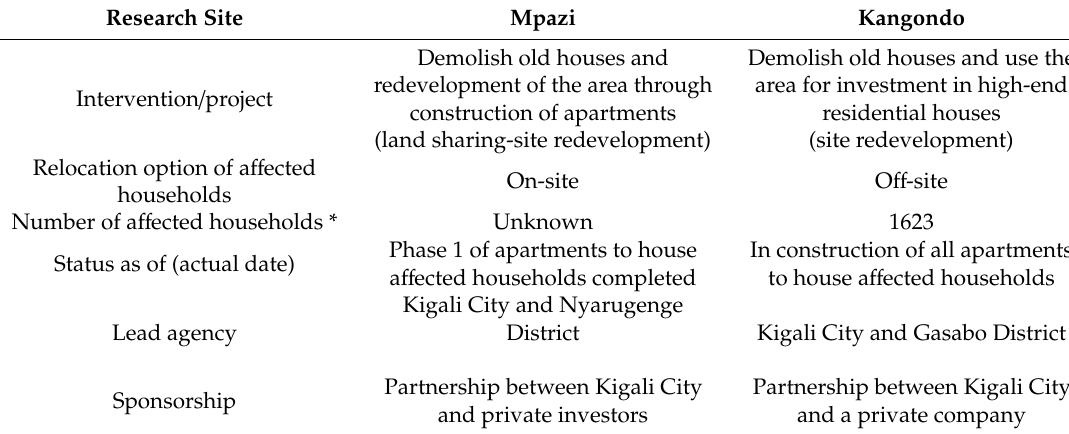
Table 1. Overview of research sites . 314